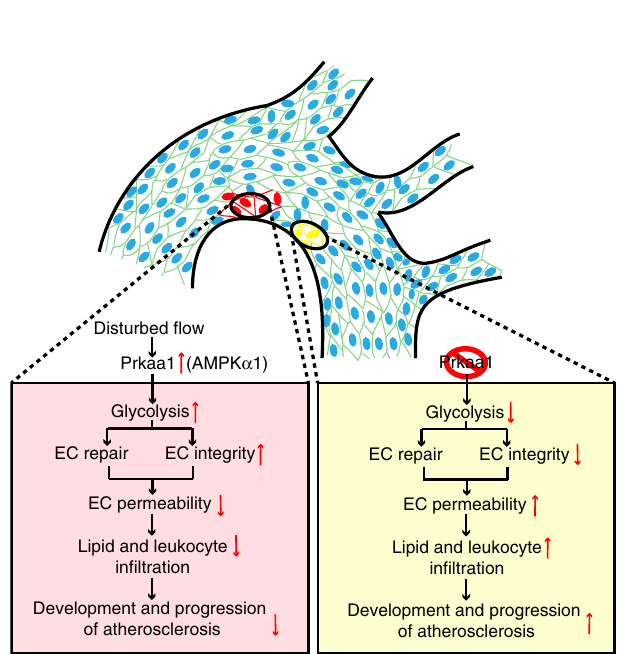
Fig. 7 Schematic diagram illustrating the mechanisms underlying the effect of AMPK α 1-mediated glycolysis on endothelial proliferation. Disturbed fl ow in atheroprone regions of blood vessels stimulates increased expression and activity of PRKAA1/AMPK α 1 in ECs. Enhanced PRKAA1/ AMPK α 1 signaling promotes increased expression of HIF1A that, in turn, drives transcription of the glycolytic enzymes and consequently increased EC glycolysis. PRKAA1/AMPK α 1-mediated glycolysis is vital to support increased proliferation of ECs and thus helps to preserve EC barrier integrity in vulnerable atheroprone regions and to protect from the in fi ltration of lipids and leukocytes into the vessel wall and the subsequent development and progression of atherosclerosis. The above protective mechanisms are compromised when the AMPK α 1 pathway is The segments were washed in cell growth medium to remove blood from the intra- aortic lumen and were then placed with the lumen side onto the collagen matrix- coated 24-well plates. Three to fi ve days later, when cellular outgrowth from the aortic segments was visible, the aortic segments were removed from the collagen matrix. The matrix was digested with 1 mg/ml collagenase D (Cat. No. 11088882001; Sigma) for 10 min at 37 °C. The subsequent cell suspensions were centrifuged, and the cells were re-suspended in complete medium, reseeded onto a T25 tissue culture fl ask, and then cultured in EGM-2 medium at 37°C in a humidi fi ed incubator with 5% CO 2 .